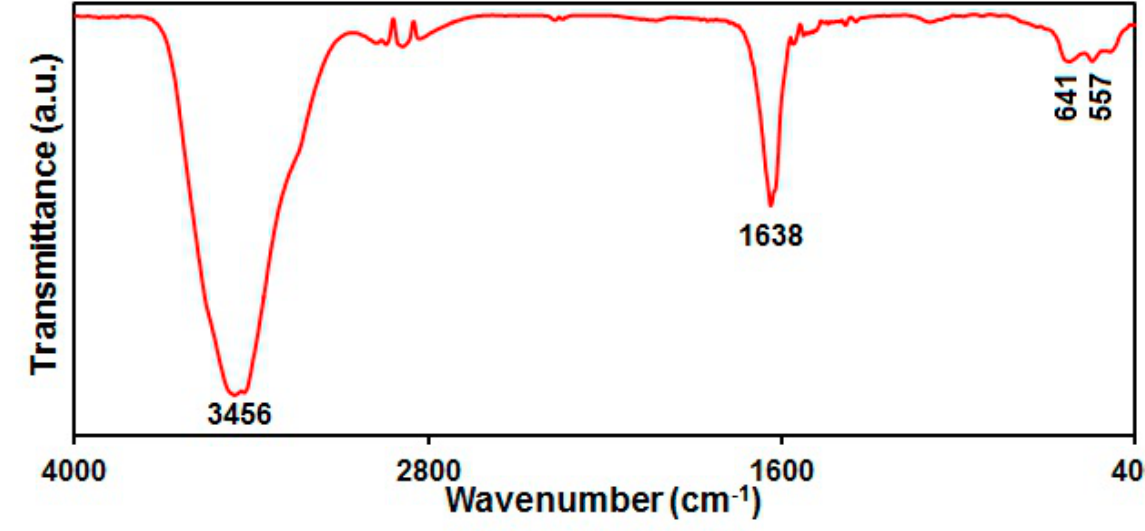
Figure 4. FT-IR spectrum of hierarchical flower-like NiCo 2 O 4 nanoplates.